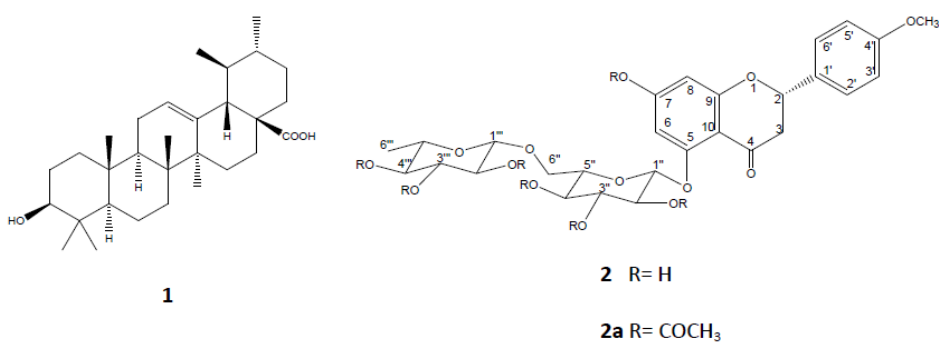
Figure 4. Ursolic acid ( 1 ), isosakuranetin-5- O -rutinoside ( 2 ), and isosakuranetin-5 O - rutinoside heptaacetate ( 2a